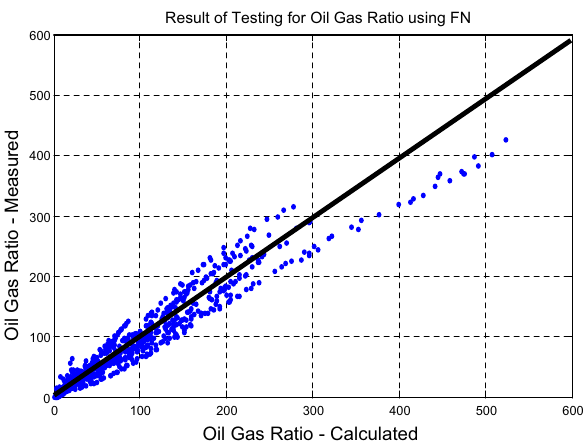
Fig. 13 Cross-plot of R